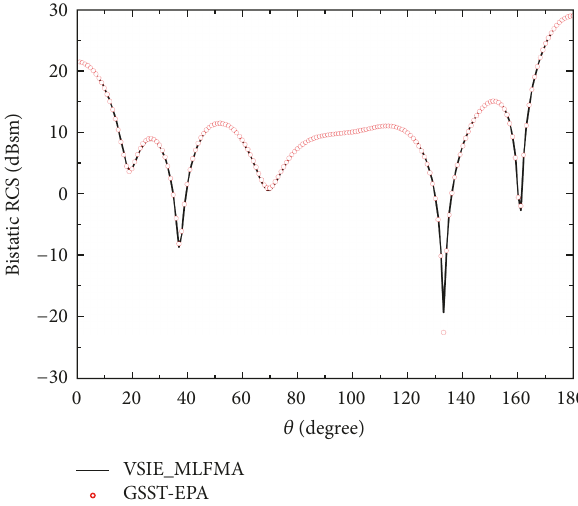
Figure 11: The bistatic RCS of a 5 × 5 sphere array; HH polarization at 300